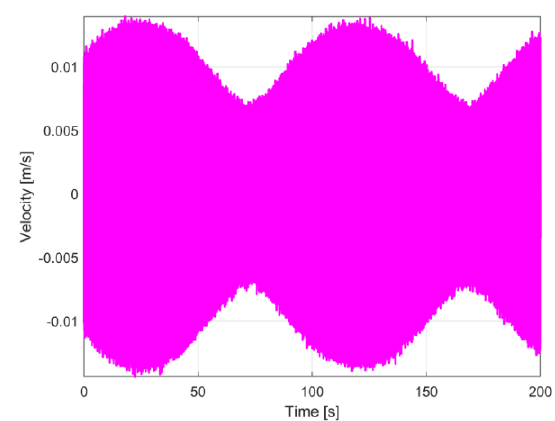
Figure 6. The result of the numerical derivative of the evolution from Figure 5b (vibration velocity, practically similar with Figure 3).